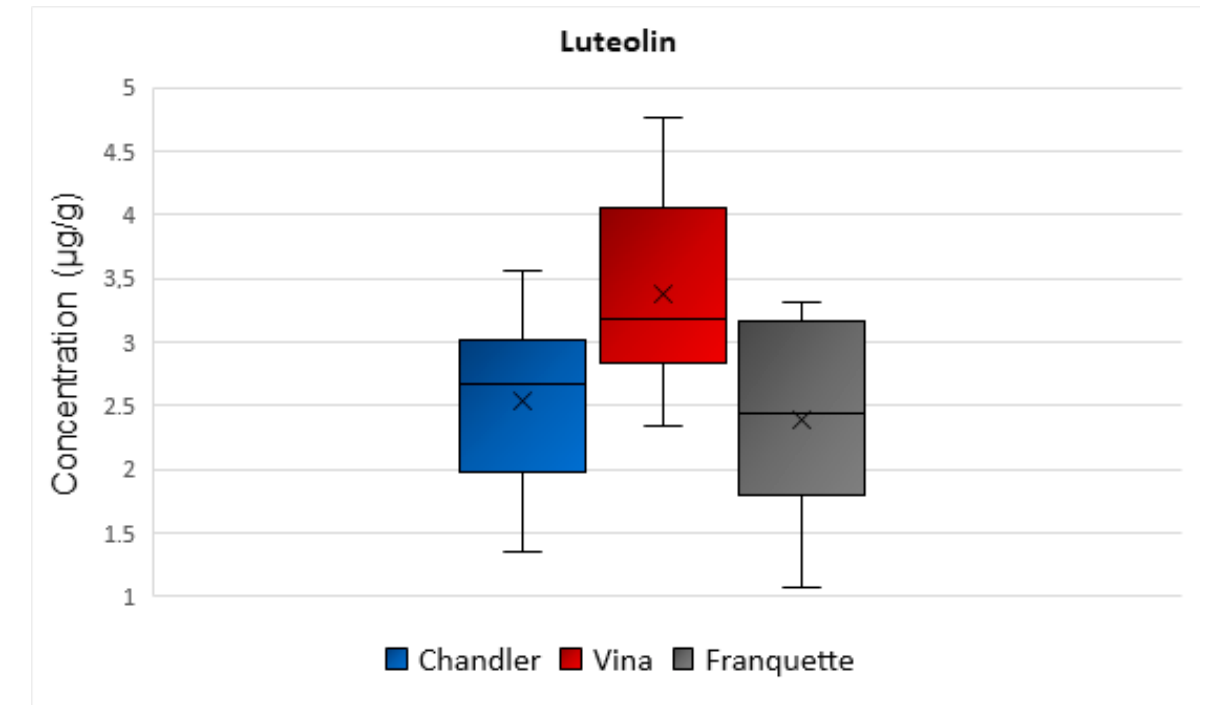
9 of 17 Figure 4. Box and Whisker plot for the concentration of myricetin among walnut septa belonging to the Chandler, Vina, and Franquette varieties. 2.3.4. Luteolin The mean concentration values of luteolin were equal to 3 μ g/g, 3 μ g/g, and 2 μ g/g in Chandler, Vina, and Franquette walnut septa, respectively (Figure 5). Statistically sig- nificant differences were observed among the luteolin concentrations determined in septa of the different varieties ( p = 0.039). As for its biological action, luteolin is a naturally oc-